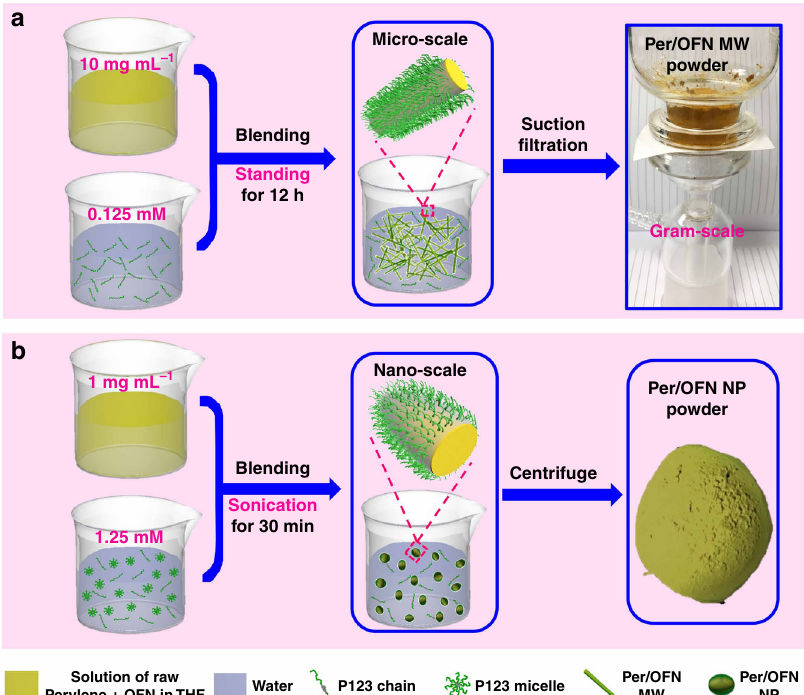
Fig. 1 Illustrations of preparation processes. Morphologies (middle) and powder pictures (right side) for the micro/nanococrystals (taking Per/OFN cocrystals as representative here, other cocrystals were prepared via the same procedures). a Preparation procedure of Per/OFN microwires (Per/OFN MW), gram-scale cocrystals (ca. 1.95 g) can be obtained from 200 mL of THF solution (10 mg mL − 1 ) of chromophore/OFN, concentration of P123 is 0.125